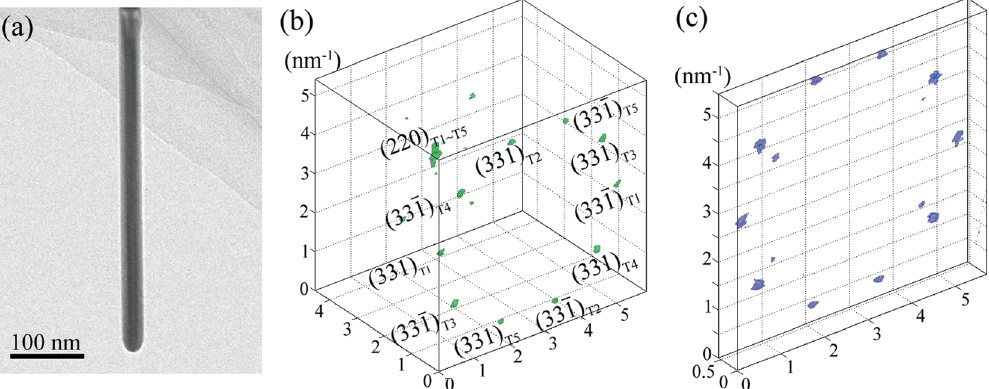
Figure 2. The 3D electron diffraction mapping result for a Ag FTNW. ( a ) The TEM morphology of a Ag FTNW with a diameter about 30 nm. ( b ) The 3D reconstruction result of the intensity distribution of (331), (331) and (220) reflections from the Ag FTNW shown in ( a ). ( c ) The reciprocal volume extracted from ( b ), containing (331) and (331) reflections.